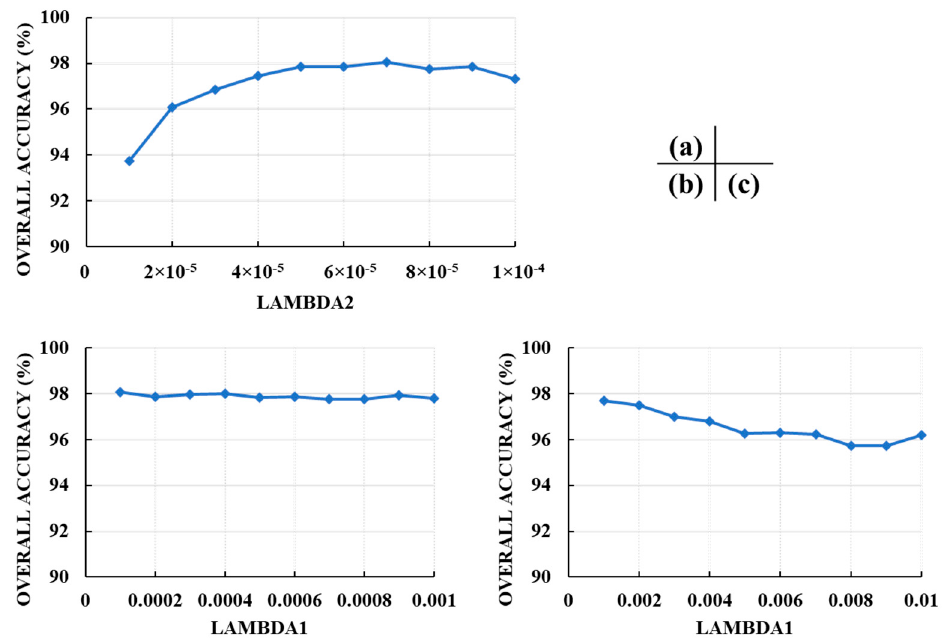
Figure 10. Parameter sensitivity analysis of the model. ( a ) E ff ect of parameter λ 2 in truncated IND PINE with 10 training samples per class ( λ 1 = 1 × 10 − 4 ). ( b , c ) E ff ect of parameter λ 1 in truncated IND PINE with 10 training samples per class ( λ 2 = 7 × 10 − 5 ).